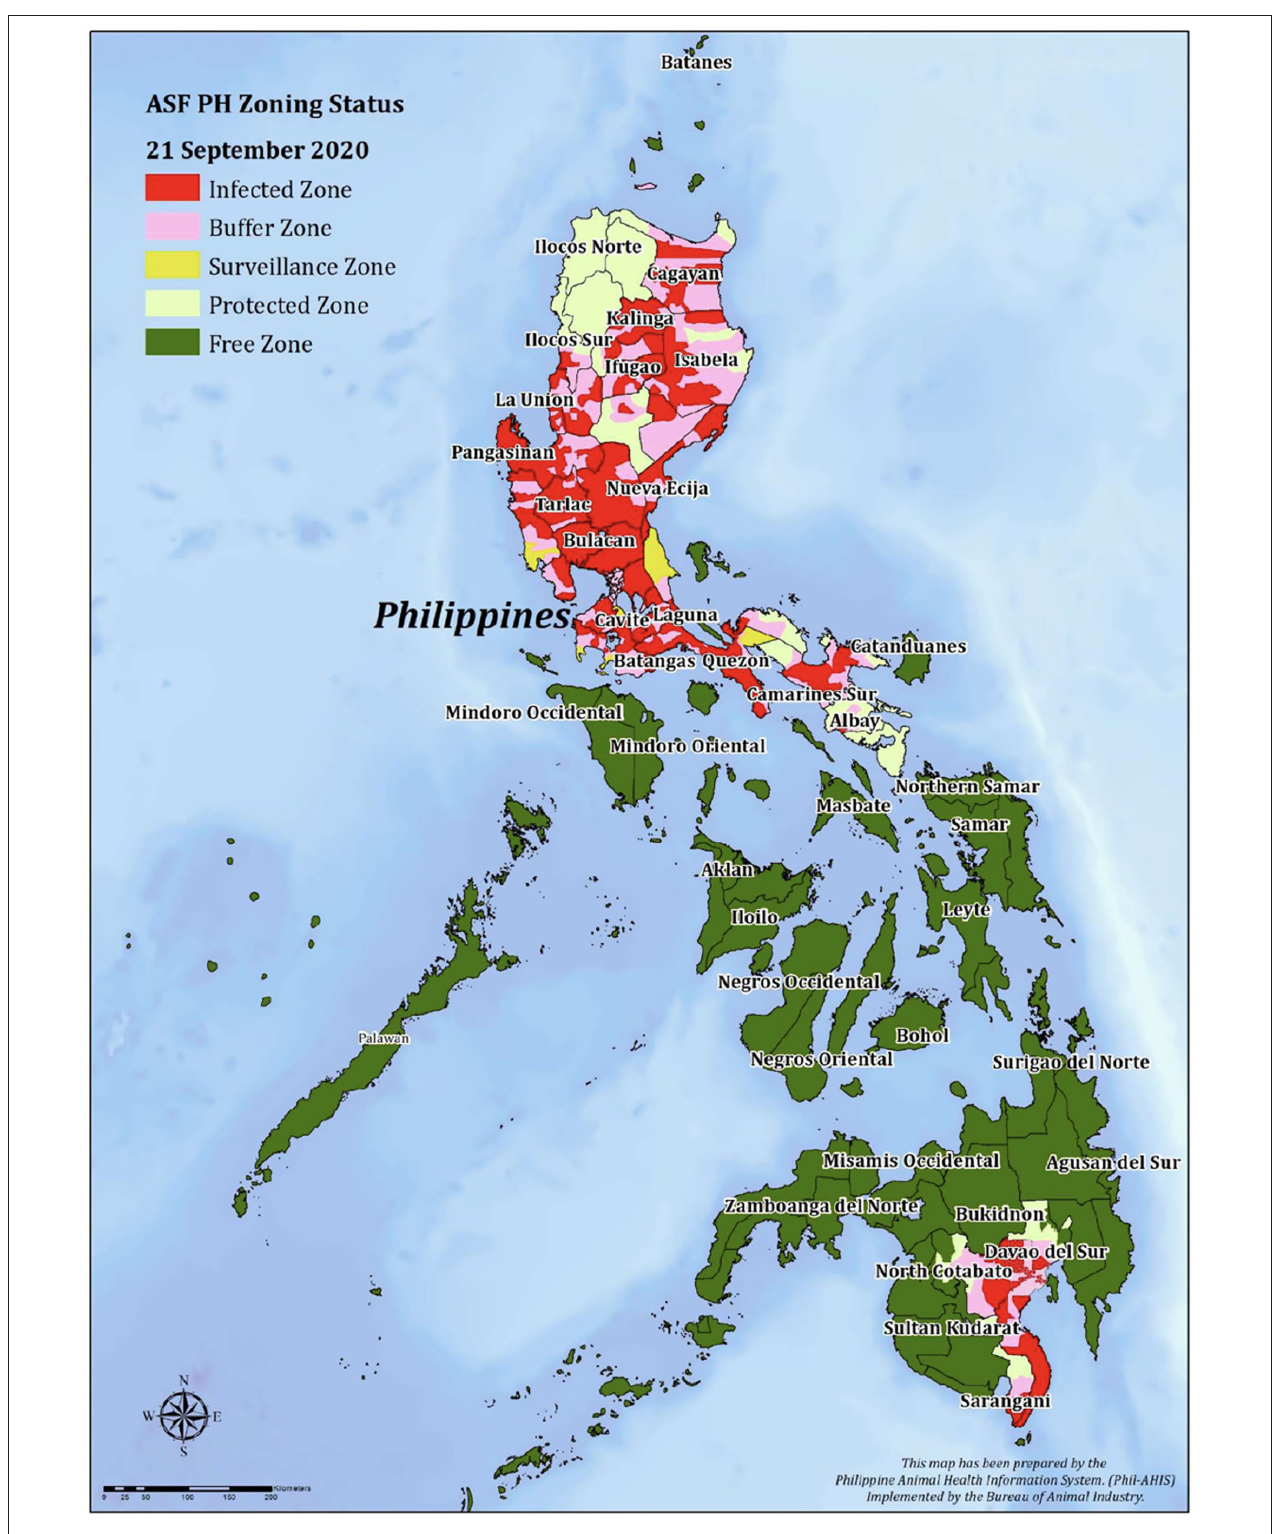
FIGURE 1 | ASF zoning status in Philippines, September